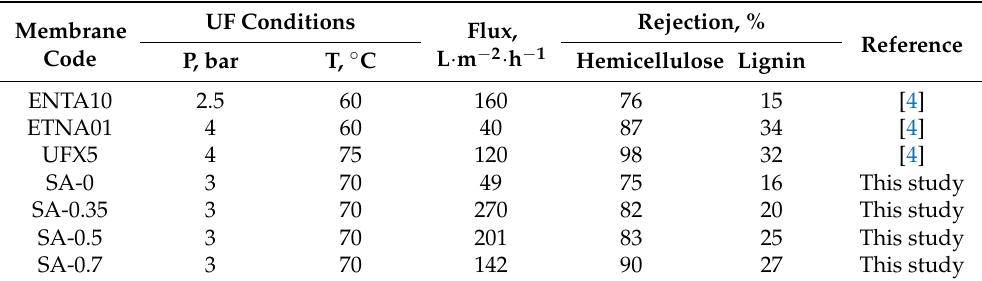
Table 6. Comparison of membrane performance in ThMP process water ultrafiltration at concentra- tion of hemicellulose 2 g · L − 1